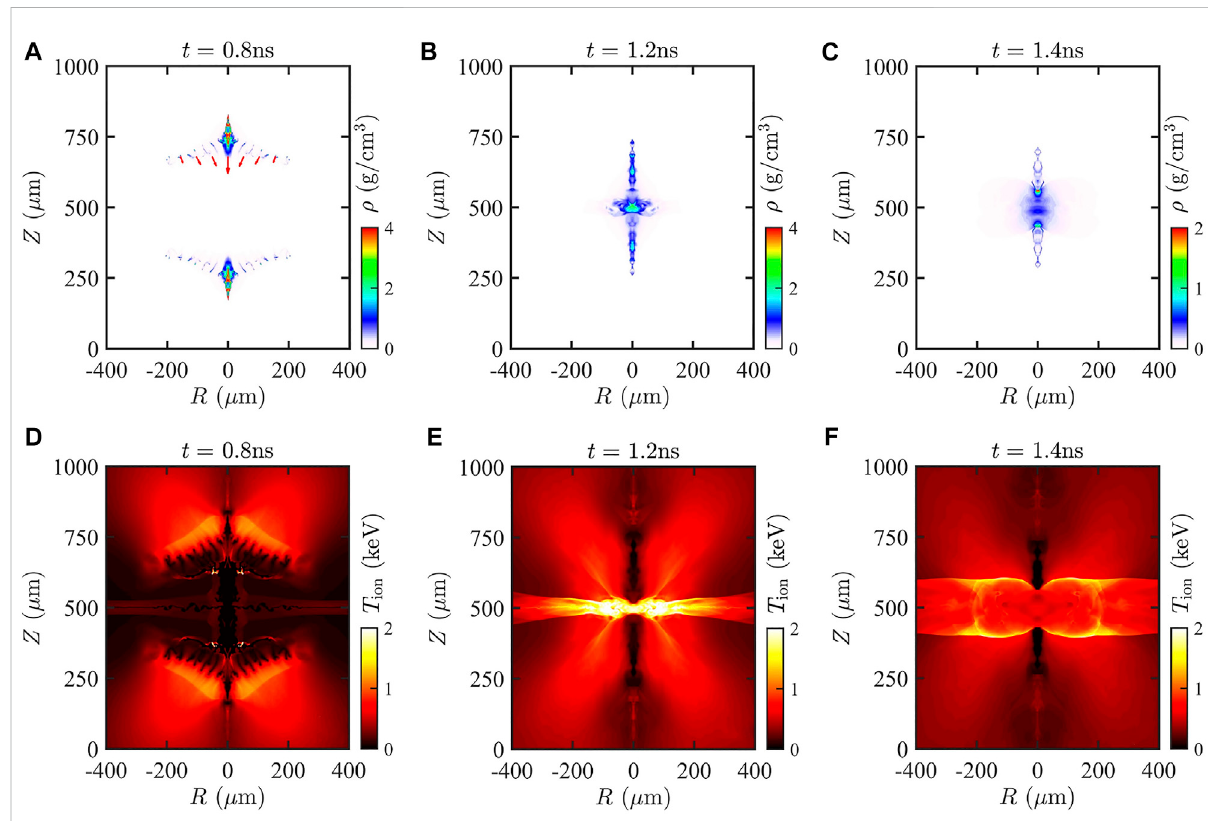
FIGURE 4 Spatial distribution of density at t (cid:2) 0 . 8ns (A) , t (cid:2) 1 . 2ns (B) , and t (cid:2) 1 . 4ns (C) . The low panel (D – F) shows the ion temperature corresponding to the same moments. The arrow in (A) represents the velocity